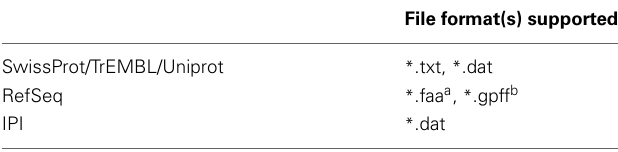
Table 1 | List of the different file formats supported by PeptideManager for the different public protein database